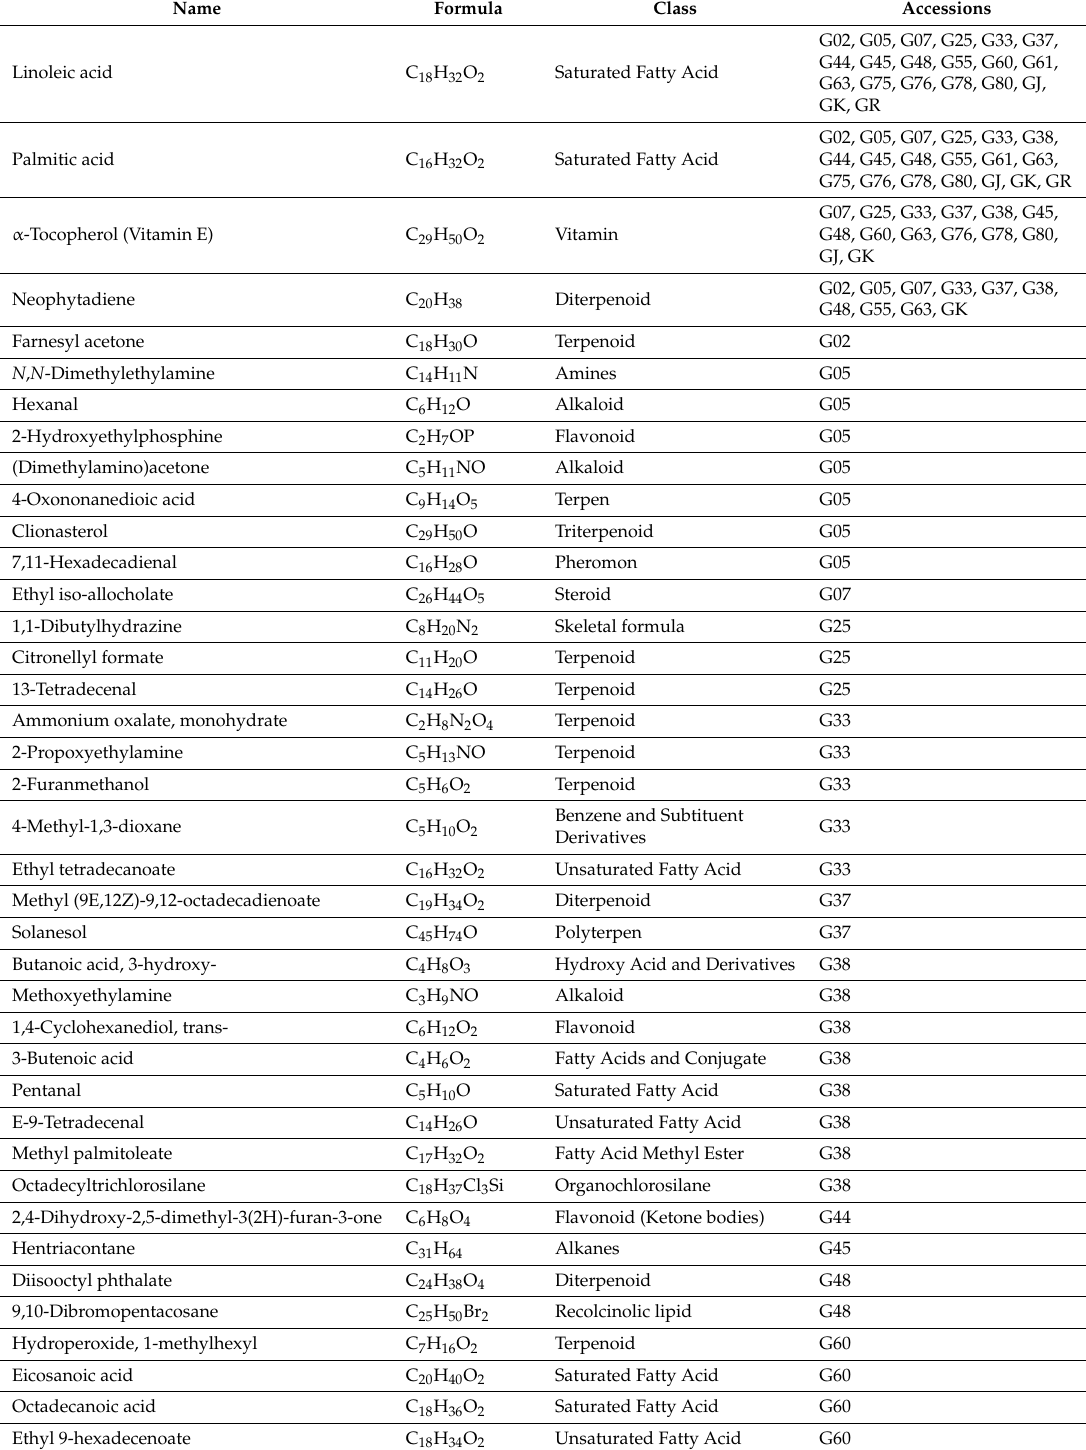
Table 1. Metabolite compounds from untargeted metabolomics analysis in eggplant fruit using